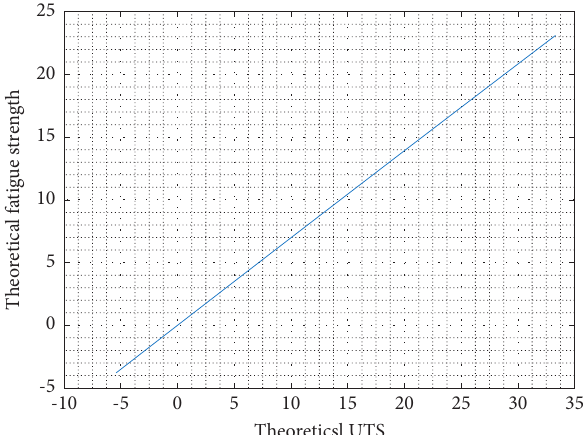
Figure 10: Theoretical fatigue strength v/s theoretical UTSe for similar materials.